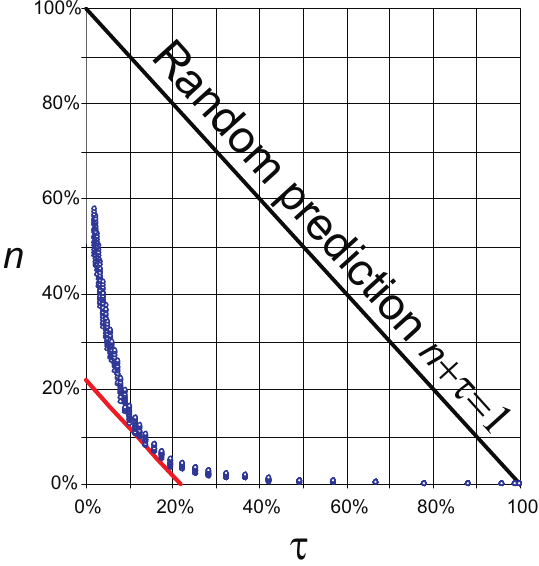
Fig. 13. The error diagram for CLF (hourly variation R ∗ computed from minute values).